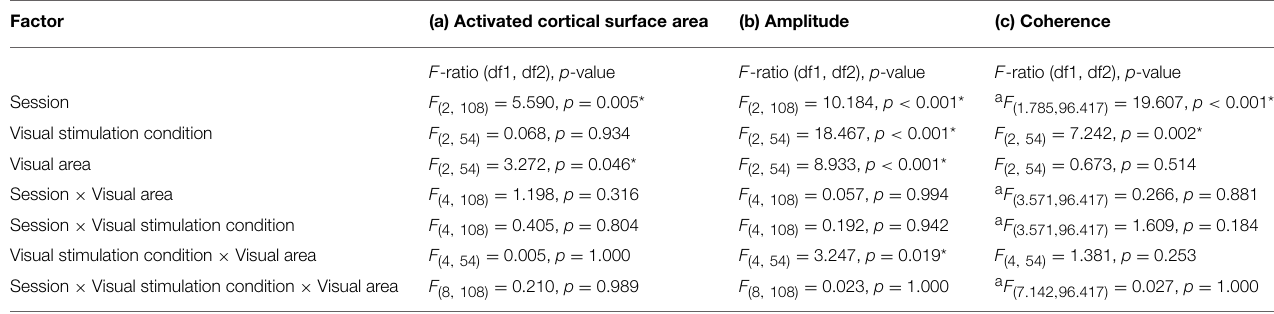
TABLE 1 | Results from repeated measures analyses for (a) activated cortical surface area, (b) responses amplitude, and (c) coherence.